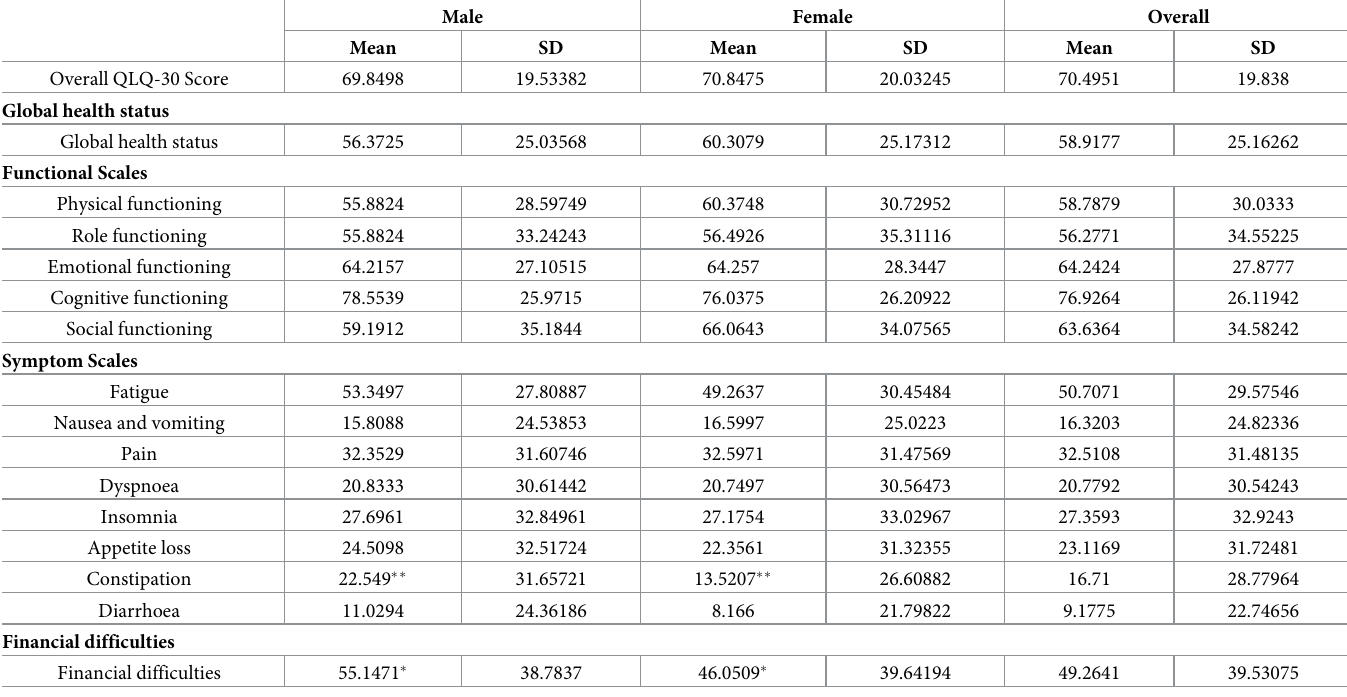
Table 4. The mean scores of Cancer Quality of Life Questionnaire-Core 30 (EORTC QLQ-C30).